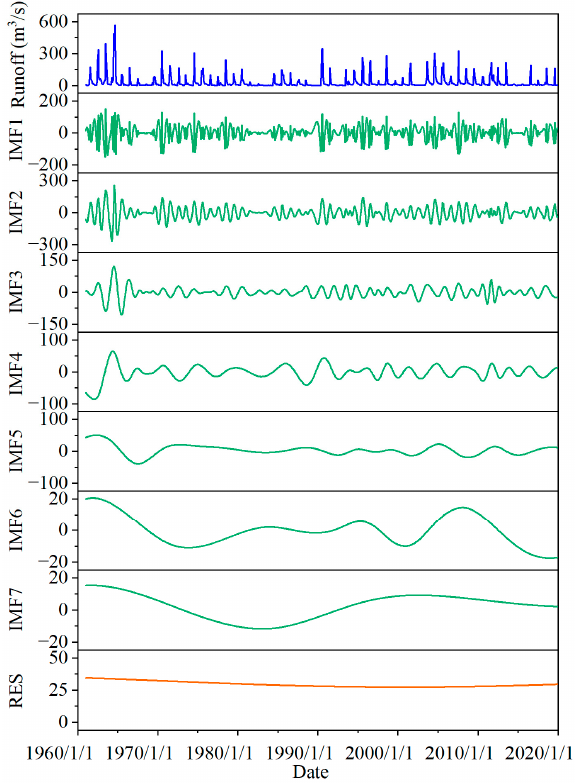
Figure 15. The decomposition results of the CEEMDAN method for runoff at Beiwang station.